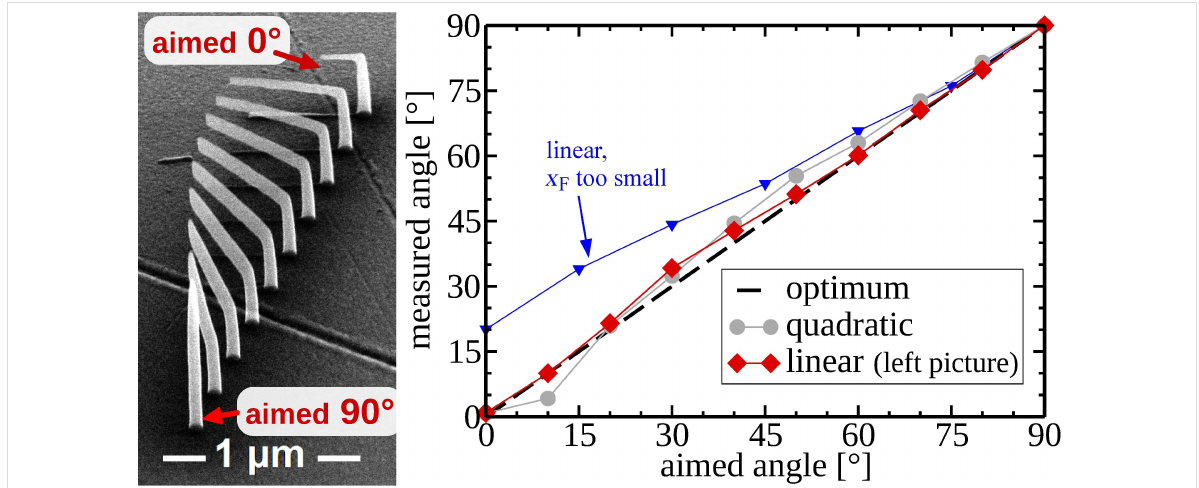
Figure 7: Angle-test structure consisting of several elements. Each element has a vertical pillar and a tilted edge with an inclination angle ranging from 0° to 90°. In the right plot the measured angles are plotted against the target angles for samples with the linear and quadratic interpolation func- tion for s F . The best result is obtained with the linear interpolation. For this, the biggest mismatch is at the targeted angle of 30°, where instead 34.2° were measured. The measured angles are taken from 52° tilted SEM images. Precursor: Me 3 CpMePt(IV), normal mode.